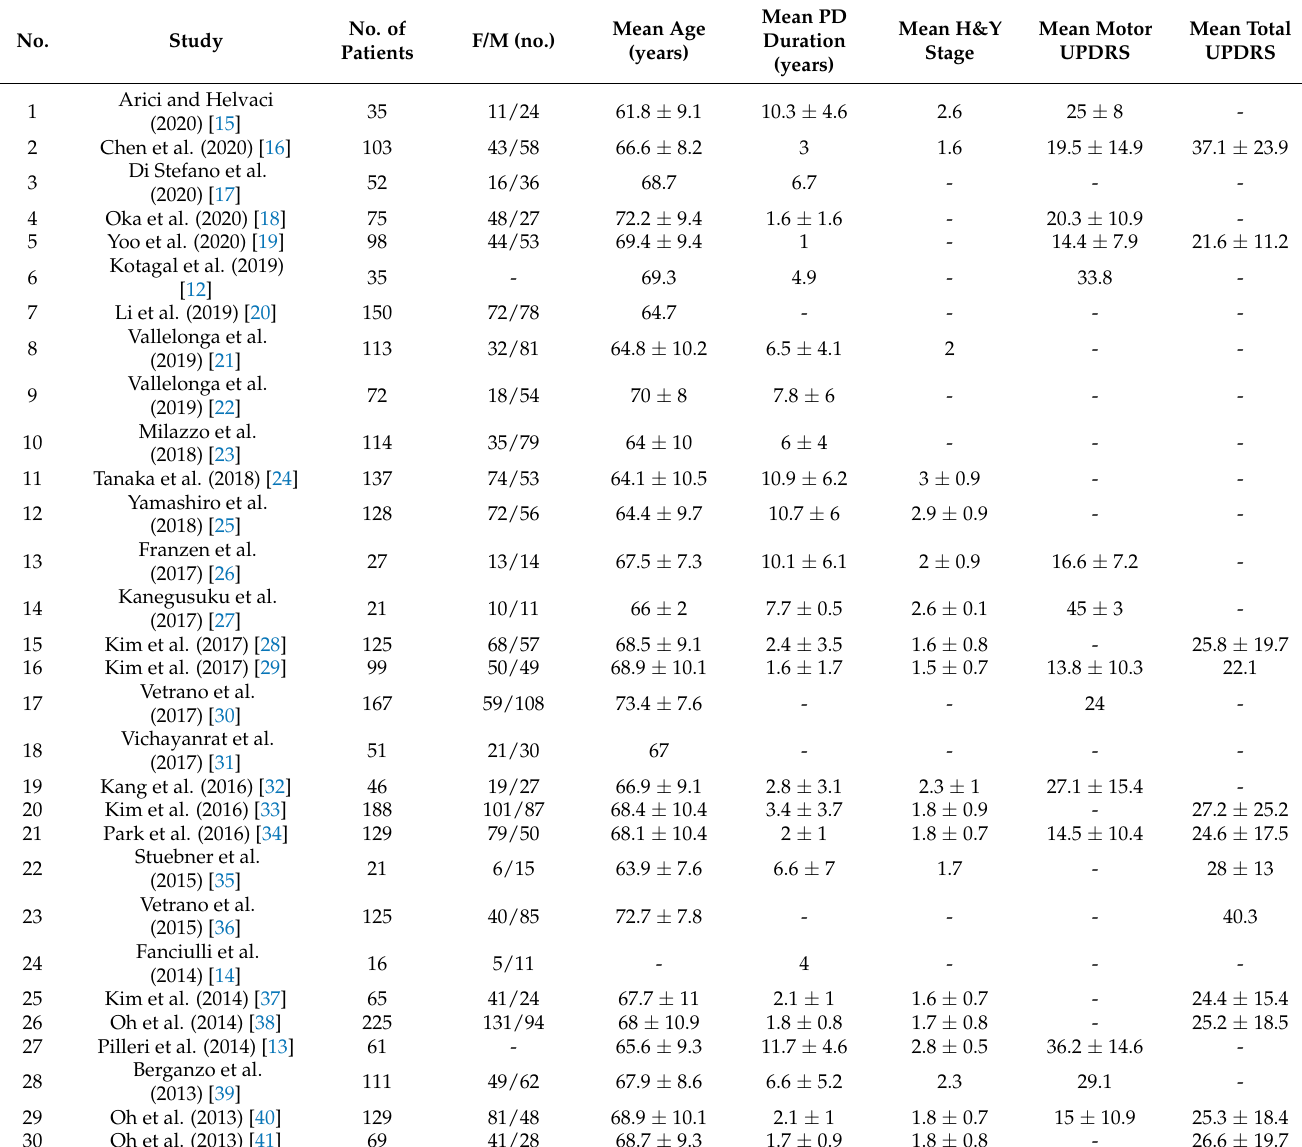
Table 1. Demographic data and Parkinson’s Disease